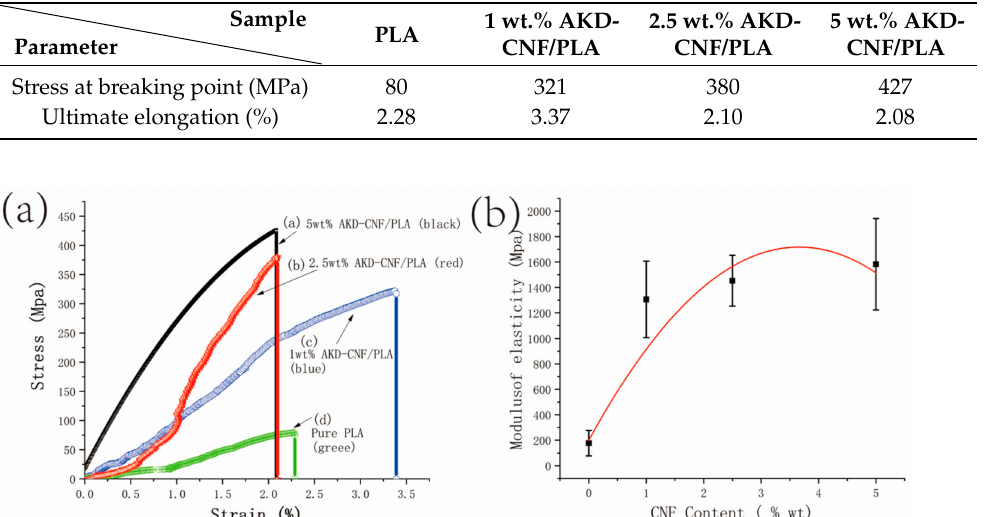
Table 3. Mechanical parameters from the stress–strain curves of samples.